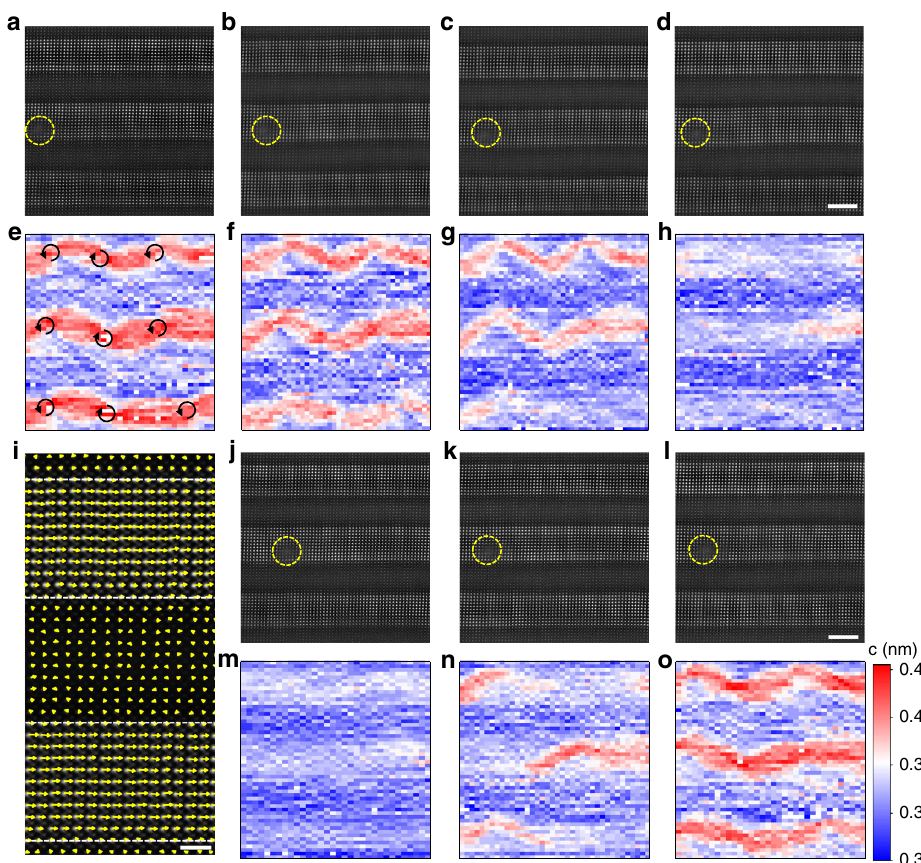
Fig. 4 Tracking stress induced vortex transition at the atomic scale. a – d A series of HAADF-STEM images acquired with applying mechanical loads. Scale bar, 4 nm. e – h The corresponding out-of-plane lattice mapping of a – d , showing the transition process. The core of the vortex survives before the transition into a pure a domain. The rotation arrows indicate the core positions of each vortex. i A high-magni fi cation HAADF-STEM image with the overlaid arrows showing the formed a domain after the transition. j – l HAADF-STEM images acquired during the unloading process. Scale bar, 4 nm. m – o The corresponding out-of-plane lattice mapping of j – l , indicating the spontaneous recovery of the vortex after removal of the external mechanical stress. The same scale is used for all the mapping fi gures. All the HAADF-STEM images were acquired in the same region indicated by the intentionally made marker using the electron probe (see the dashed yellow